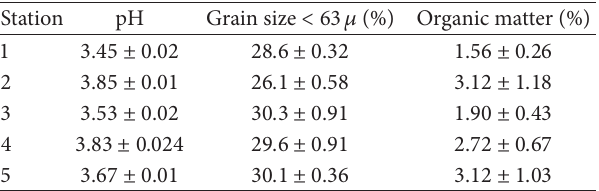
Table 5: The mean value of the selected sediments